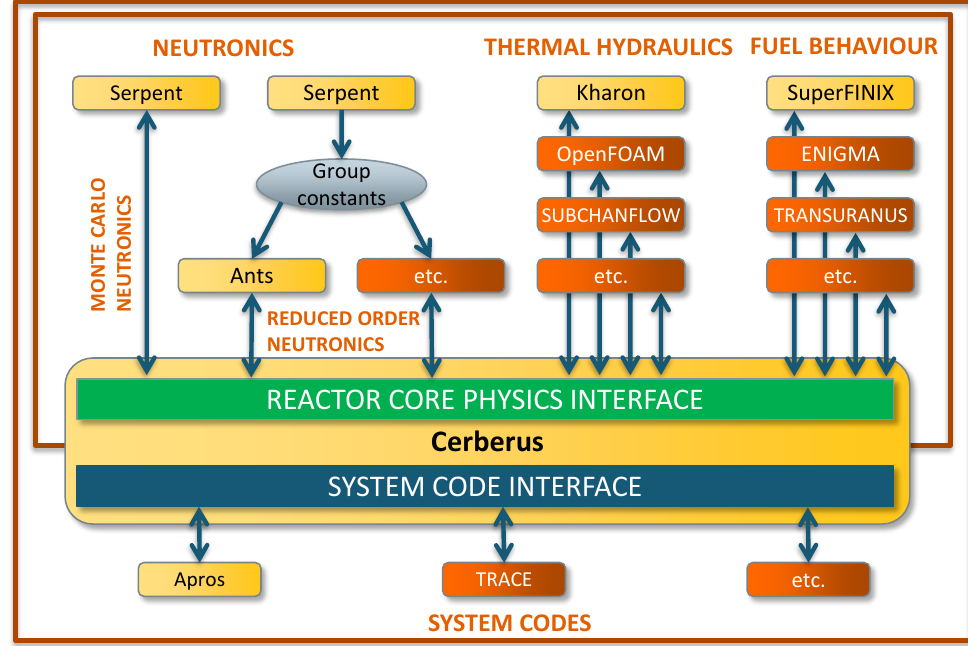
Figure 1. The Kraken computational framework. The core physics solution is coupled to system- scale simulations by outer boundary conditions. Codes developed at VTT are highlighted in yellow and third-party solvers in